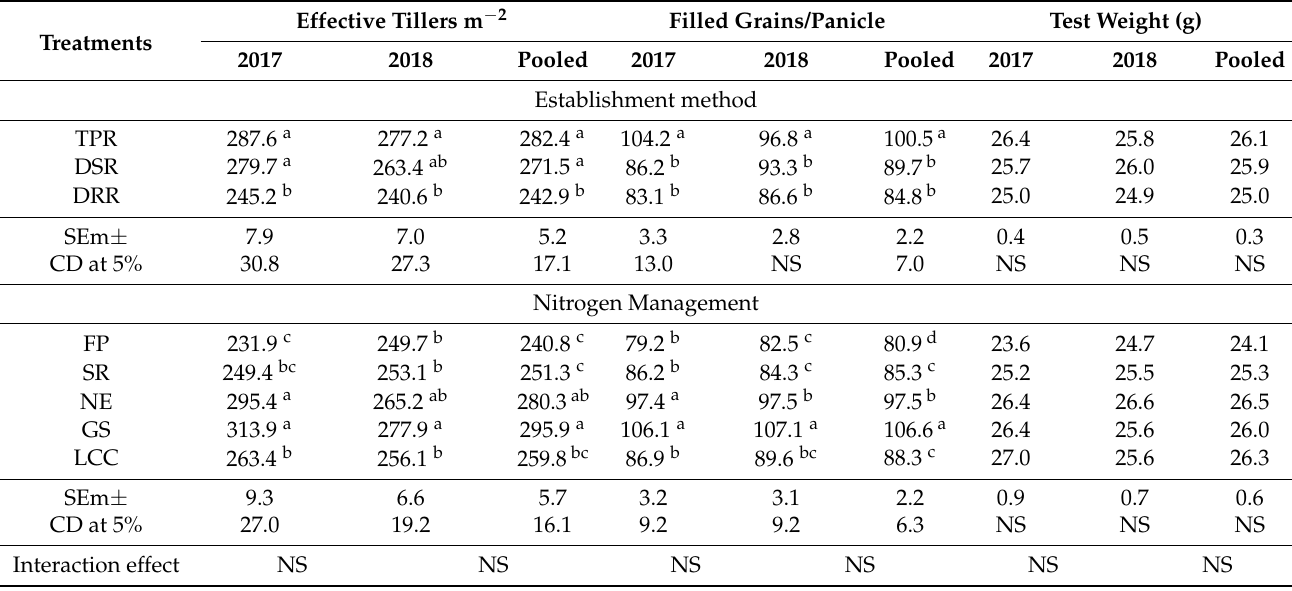
Table 5. Influence of crop establishment methods and nitrogen management on yield attributes of “Pratikhya” Kharif rice variety.